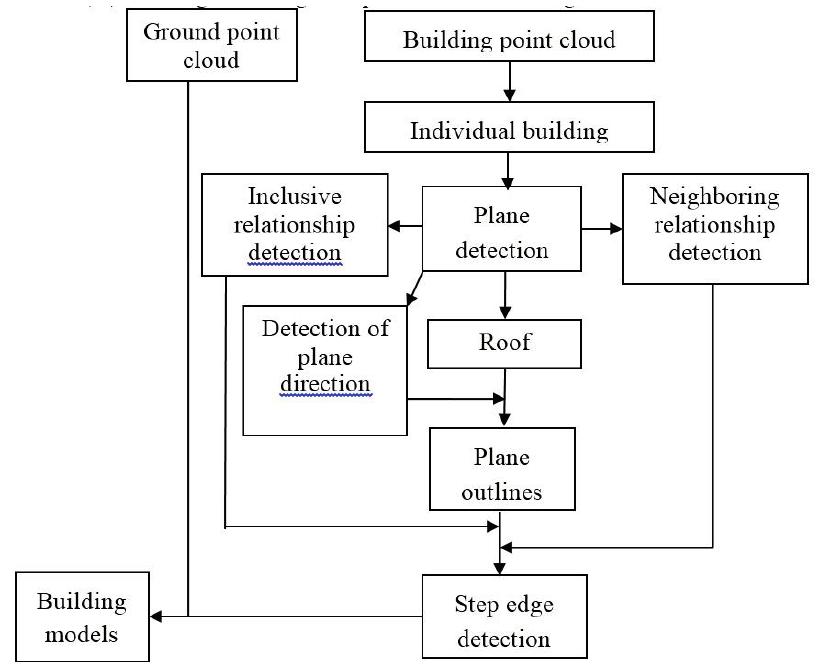
Figure 2. Procedure for 3D CAD building model